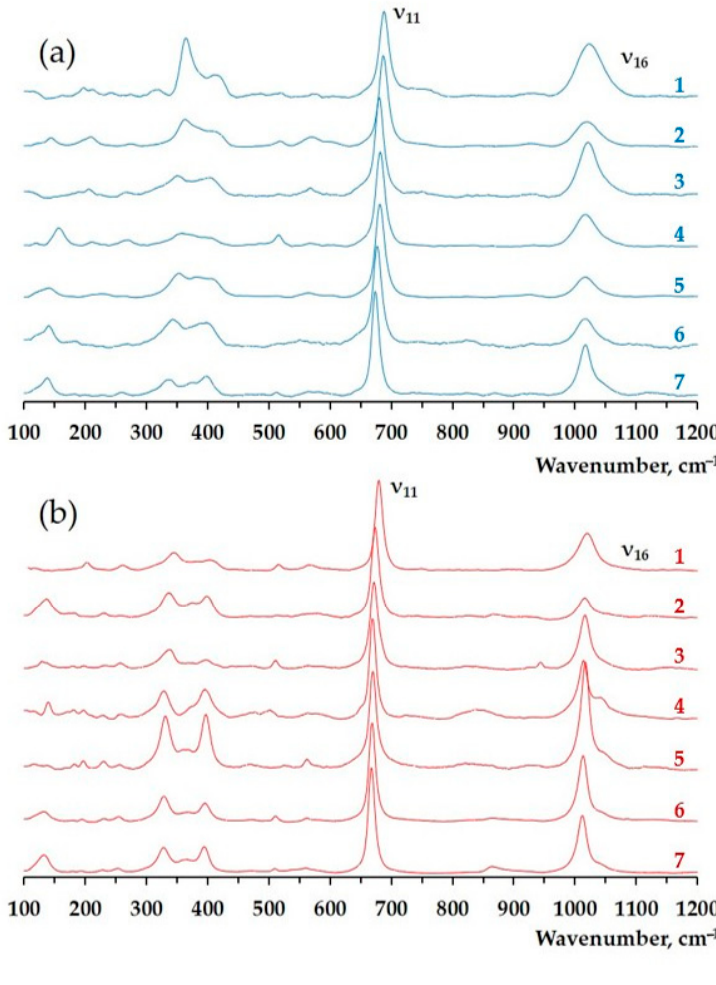
Figure 3. Raman spectra of clinopyroxenes of di ff erent parageneses: ( a ) Eclogite clinopyroxenes (1, 4, 5—inclusions in diamonds from Ebelyakh river deposits; 2,3,6,7—inclusions in diamonds from Internatsional’naya pipe); ( b ) peridotite clinopyroxenes (1—inclusion in diamond from Udachnaya pipe; 2–5—inclusions in diamonds from Internatsional’naya pipe; 6,7—clinopyroxenes from